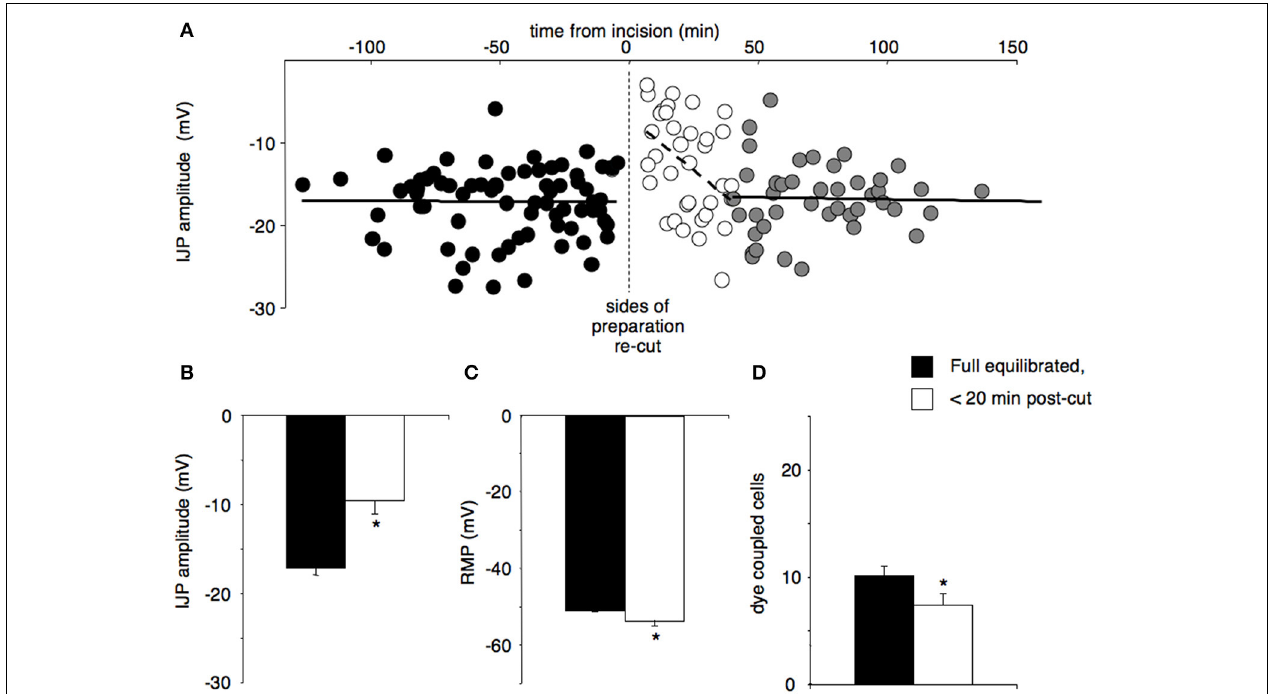
FIGURE 1 | The effects of re-cutting all four edges of a preparation, after full responses had recovered. Preparations with double rows of pins were allowed to equilibrate fully, then approximately 0.5–1mm of tissue between the rows of pins was re-cut, creating 4 new edges. (A) The amplitudes of IJPs were constant (17.2 ± 0.7mV) before the incision (black circles, cells = 73, n = 12). The amplitude of IJPs was significantly reduced immediately following the cut ( − 9 . 6 ± 1 . 5mV, open circles, P < 0 . 01,